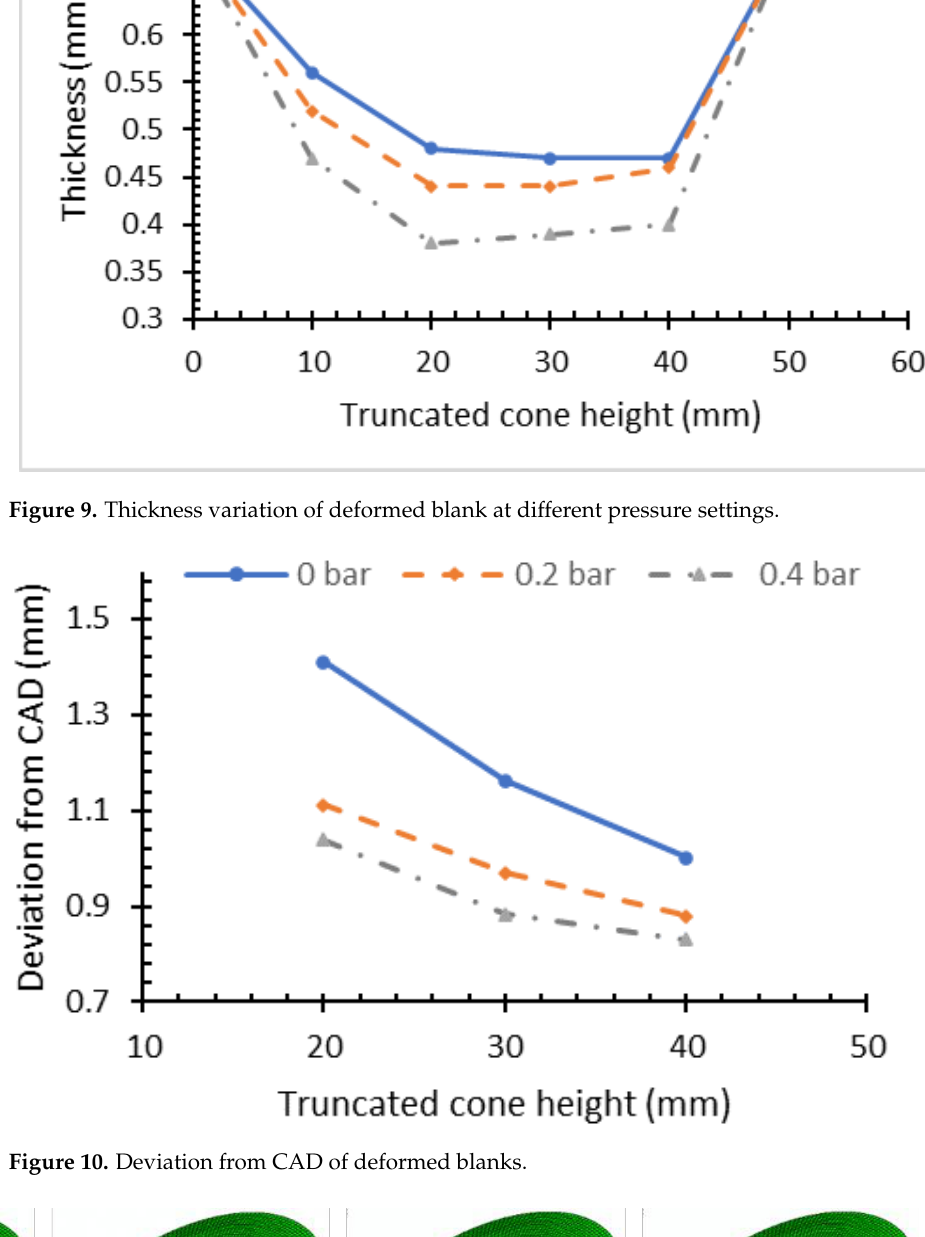
Figure 12. von Mises stress distribution for FFLD material model at ( a ) no fluid pressure, ( b ) pressure 0.2 bar, and ( c ) pressure 0.4 bar.